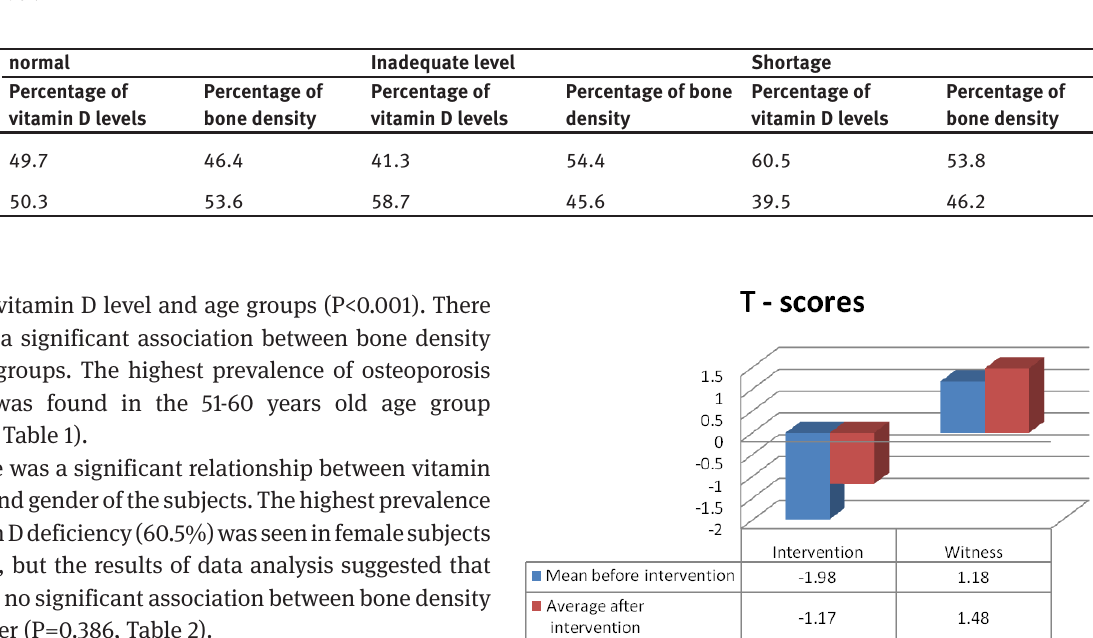
Table 2: Distribution of vitamin D level and bone density in patients referred to the Bone Density Clinic of Kowsar Hospital of Semnan during 2017 by gender.